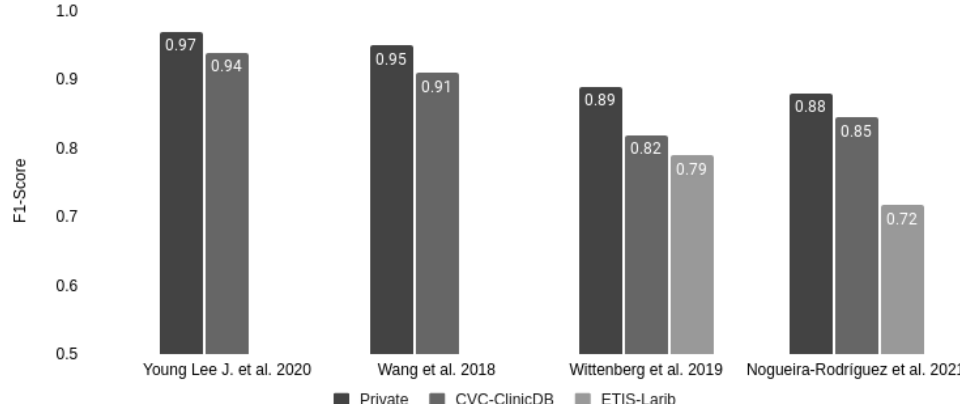
Figure 7. Comparison of F1-score decay on public colonoscopy image datasets of those studies re- porting their performance for the private test set partition.